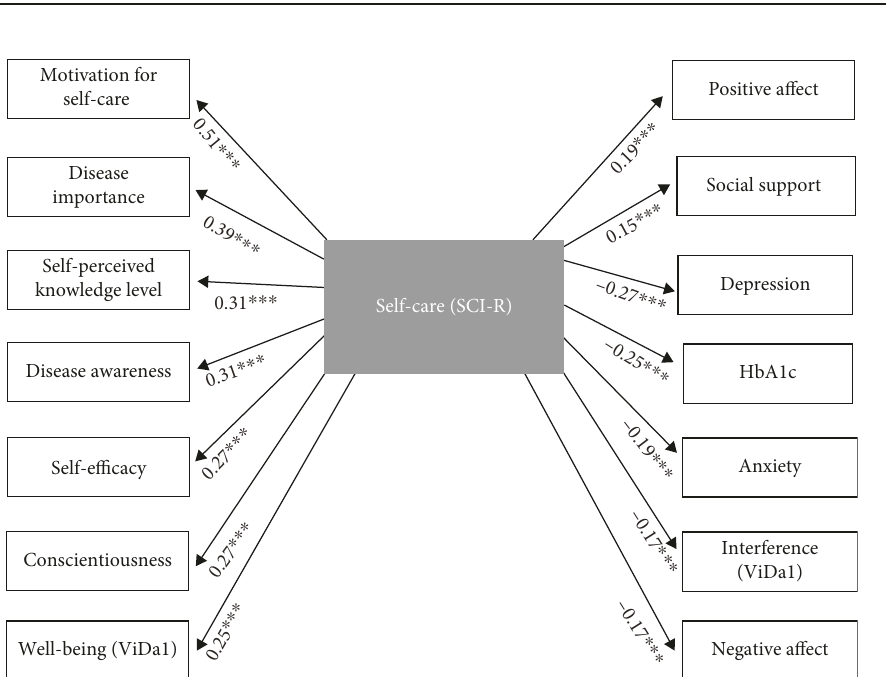
Figure 1: Signi fi cant correlations between adherence to self-care and the rest of the variables. N = 428 ; ∗∗∗ p < 001 . Bonferroni correction was